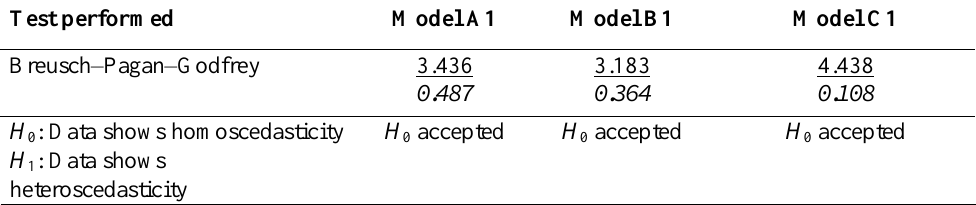
Table 4. Testing Data for